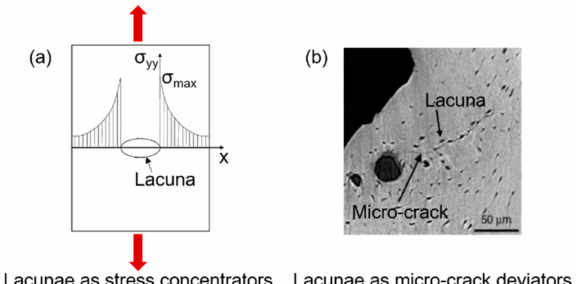
Figure 7. The dual effect of the lacunar system on microdamage: lacunae as sites for crack initiation ( a ) and lacunae as micro-crack deviators ( b ); ( b ) is adapted from